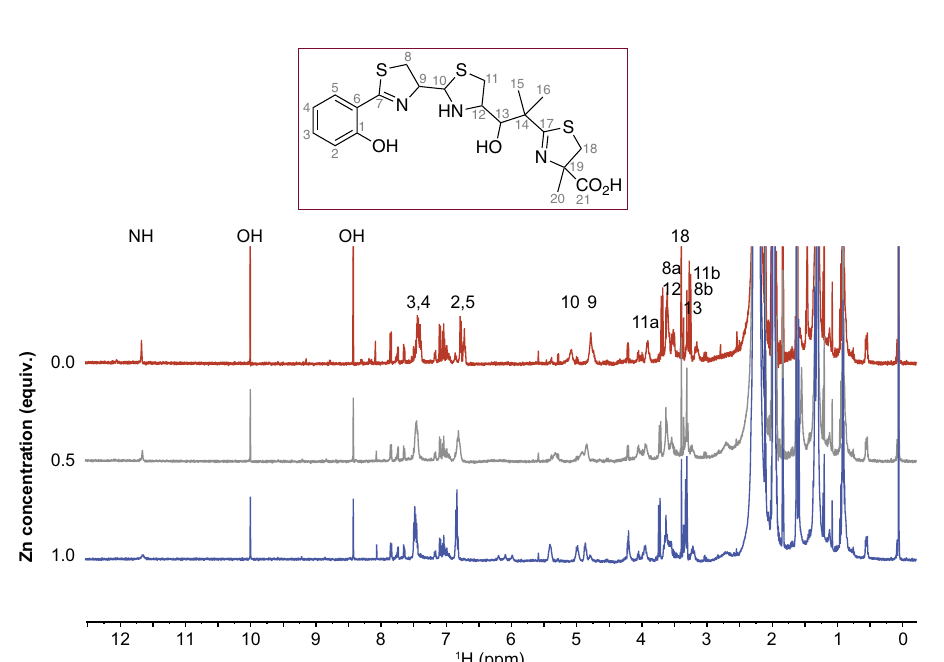
Fig. 3 1D 1H NMR con fi rms direct zinc binding to yersiniabactin. 1D 1 H NMR spectra of Ybt dissolved in CD 3 CN (top trace, 0 equivalents of Zn, red trace) as increasing zinc is titrated into the solution (0.5 equiv., gray trace), (1.0 equiv., blue trace). The loss of intensity of the NH and OH signals arises from the coordination of zinc by the corresponding N and O atoms; the signals that shift correspond to protons whose electronic environment changes due to binding of the Zn 2 + ion. Only partial binding is observed because Ybt is in rapid equilibrium between two tautomers at C10 in addition to hydrolysis that occurs at C10 49